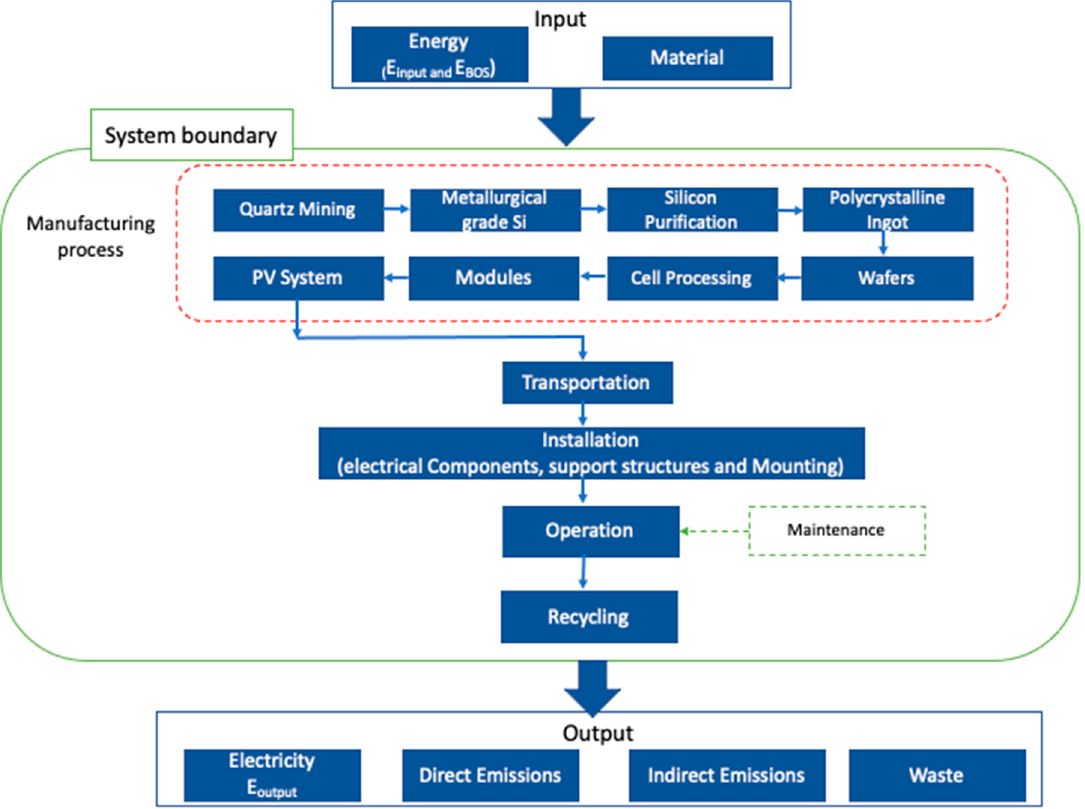
Figure 6. System boundary for the PVSS LCA in this study.